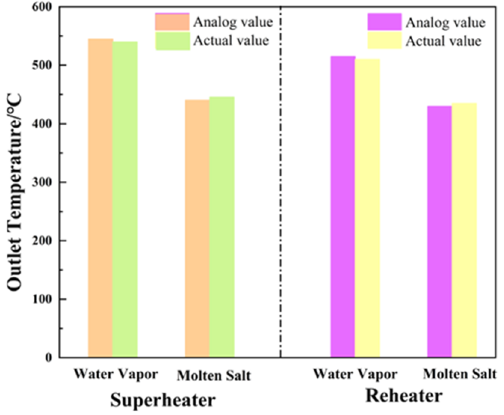
Figure 4. The verification diagram of model.